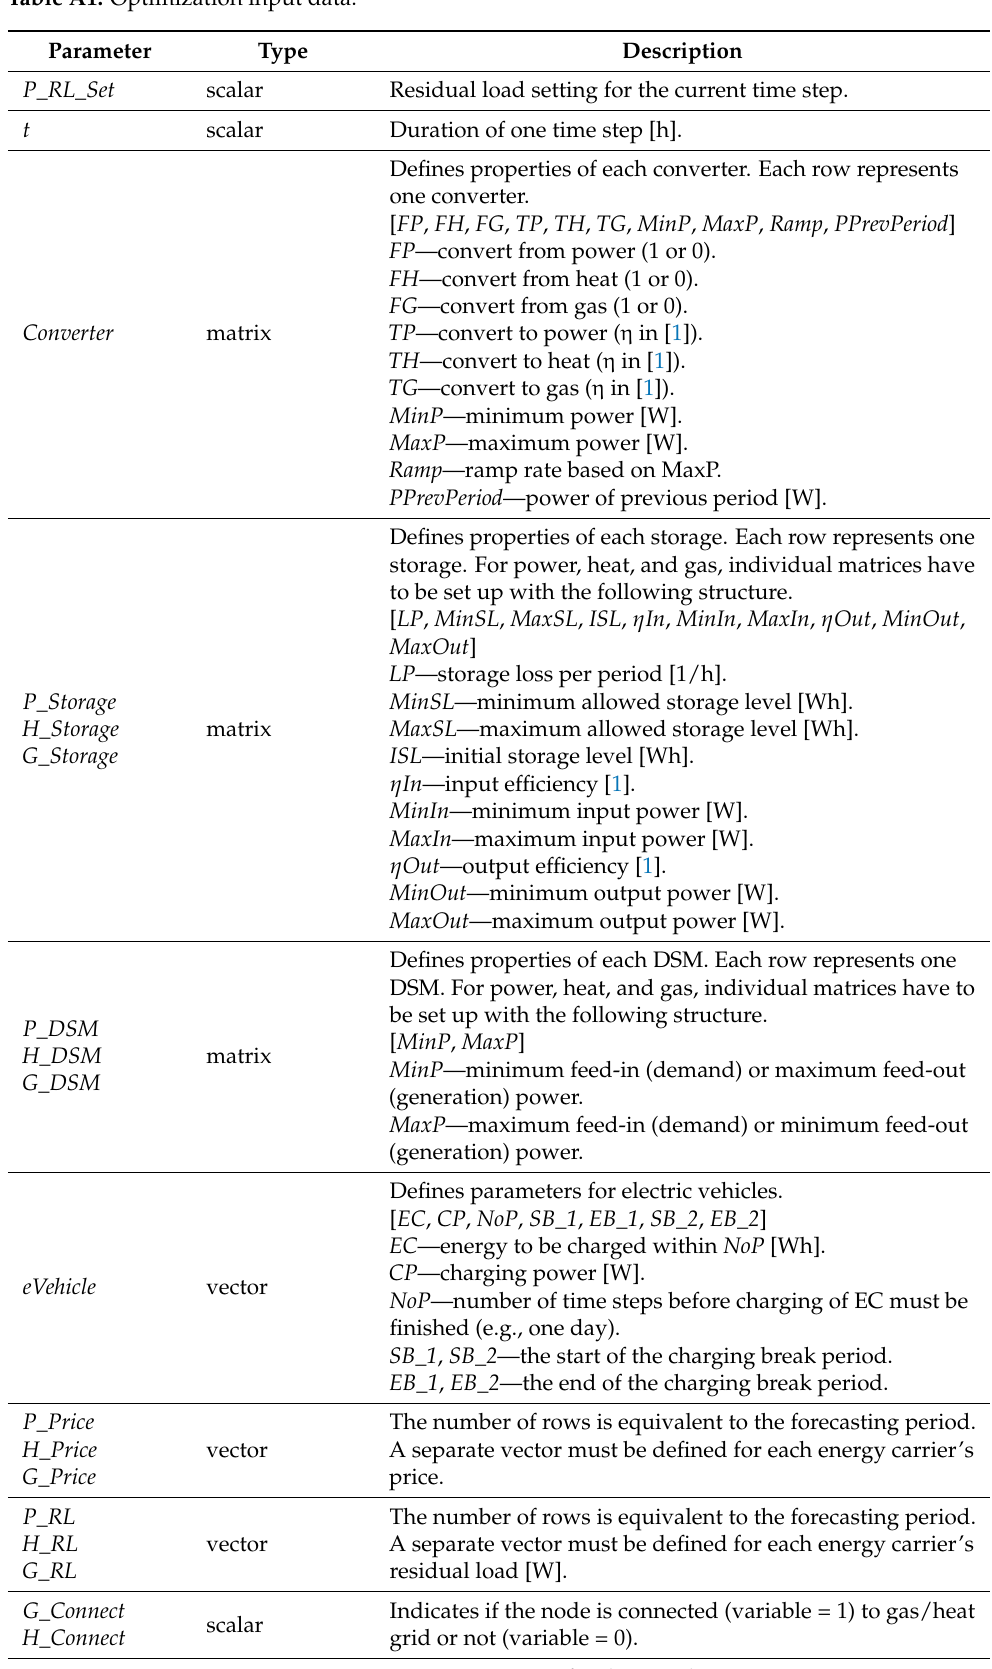
Table A1. Optimization input